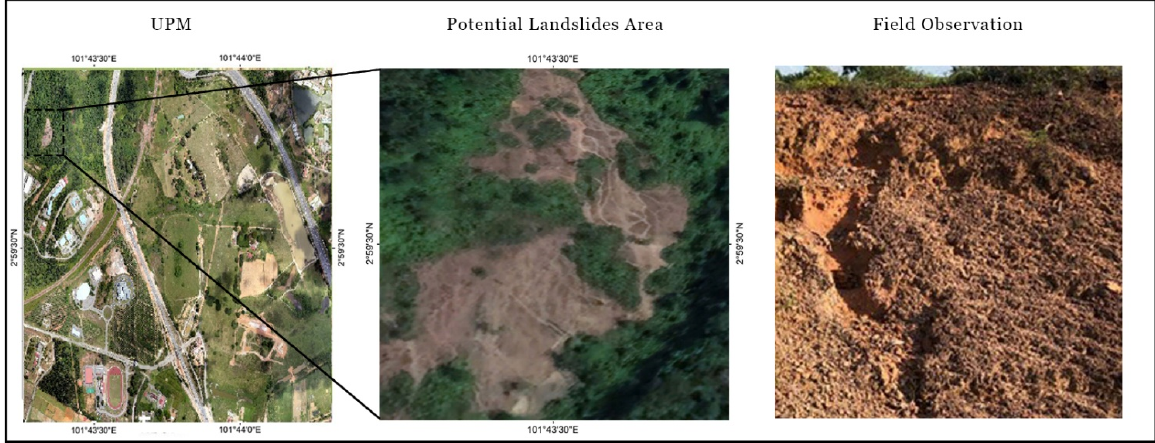
Figure 2. Landslide locations within the study area from google earth and field observation.